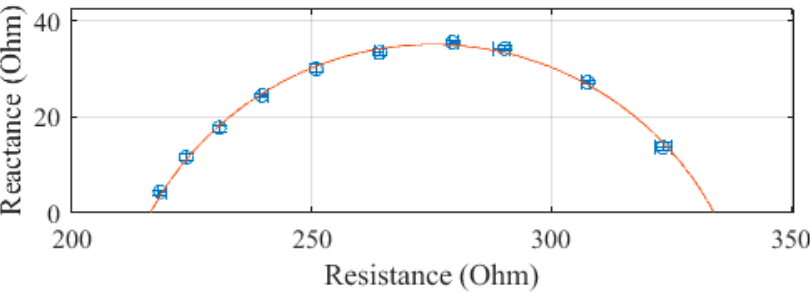
Figure 7. Cole–Cole plot of the leg impedance of subject 1 measured with the SBISD.